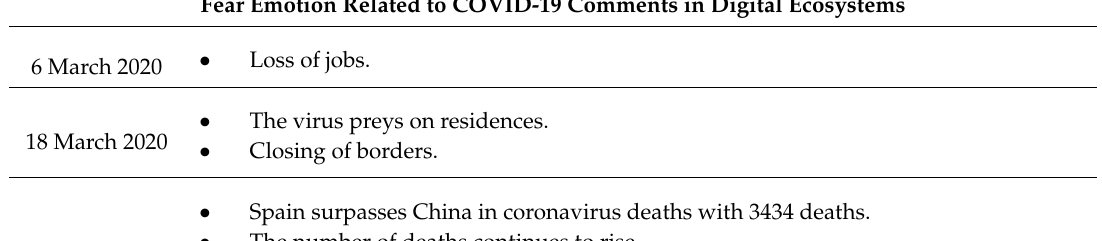
Table 2. Comments related to Fear emotion and COVID-19 in digital ecosystems. Fear Emotion Related to COVID-19 Comments in Digital Ecosystems